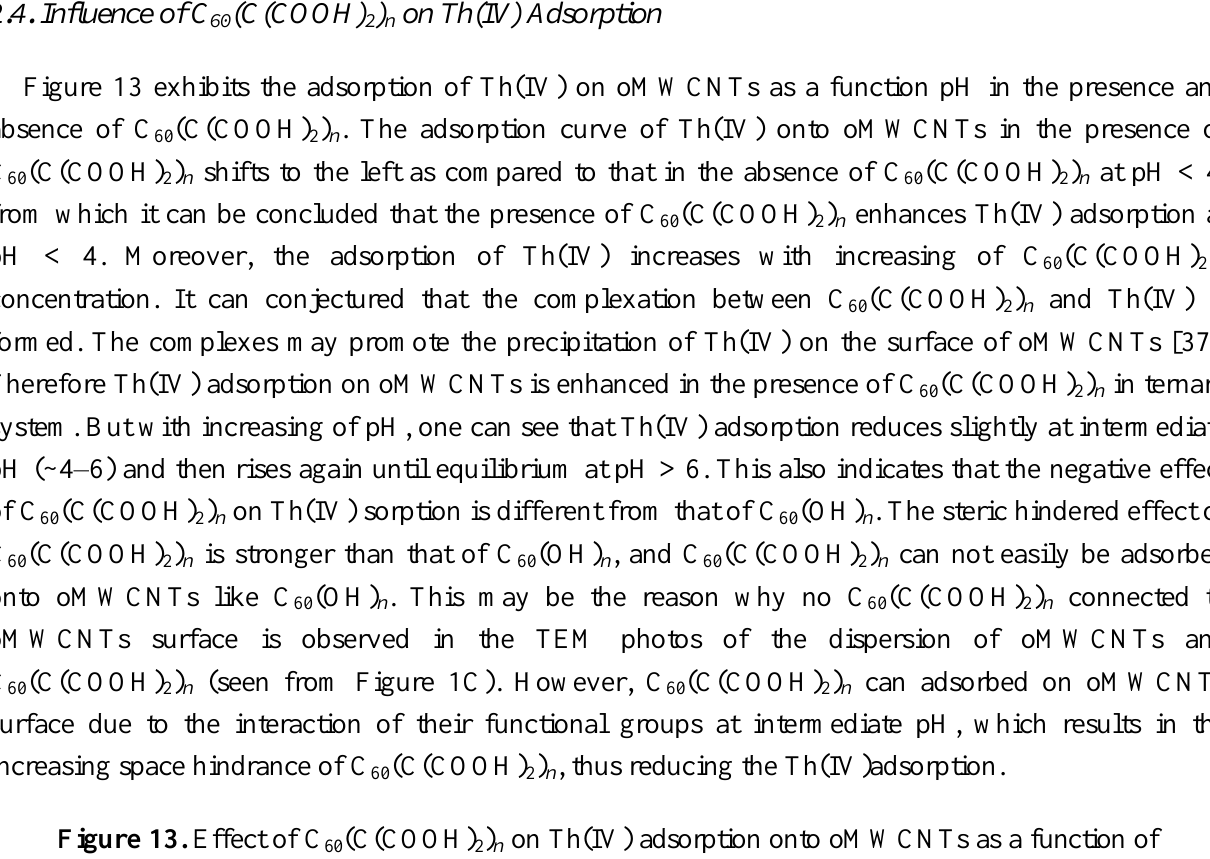
Figure 13. Effect of C